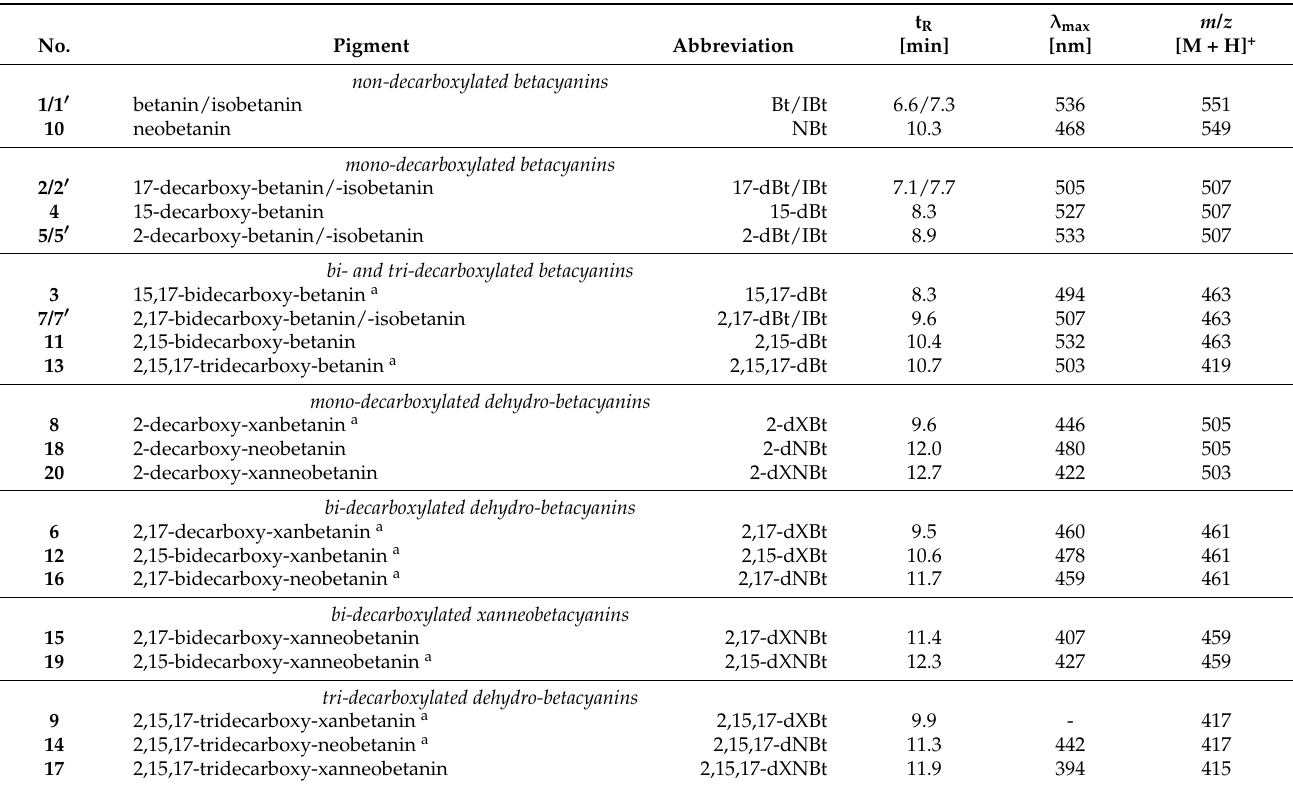
Table 1. Chromatographic, spectrophotometric, and mass spectrometric data of detected betanin- based decarboxylated and dehydrogenated derivatives in the betalain-rich extract (BRE) heated in acetate/phosphate and citrate buffers at 30, 50 and 85 ◦